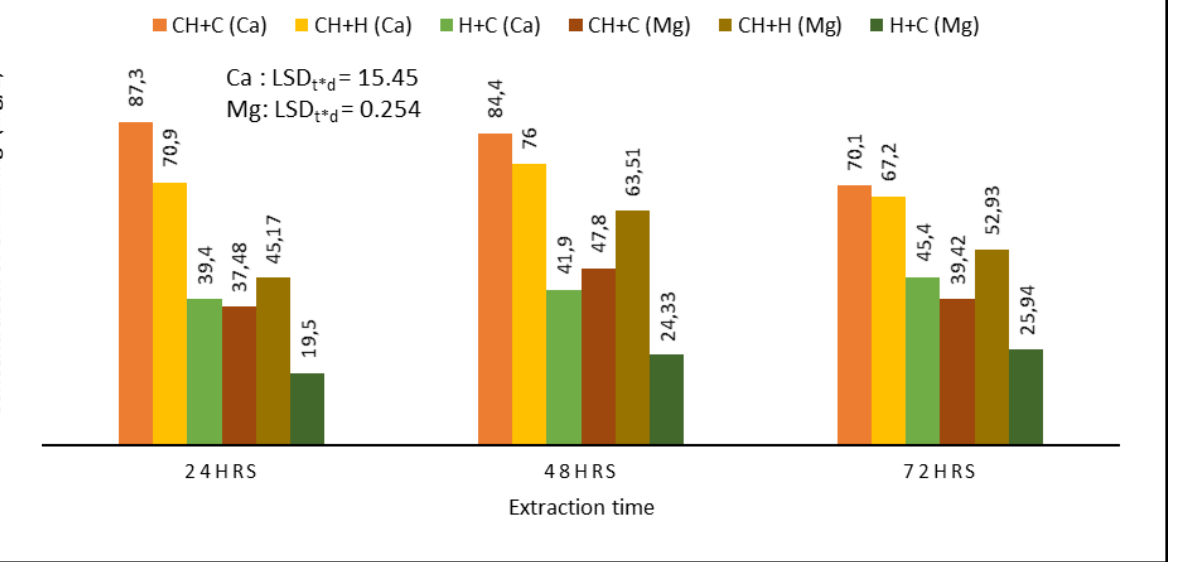
Figure 3. Determination of calcium and magnesium in different vermicompost teas over 72-h extraction period.